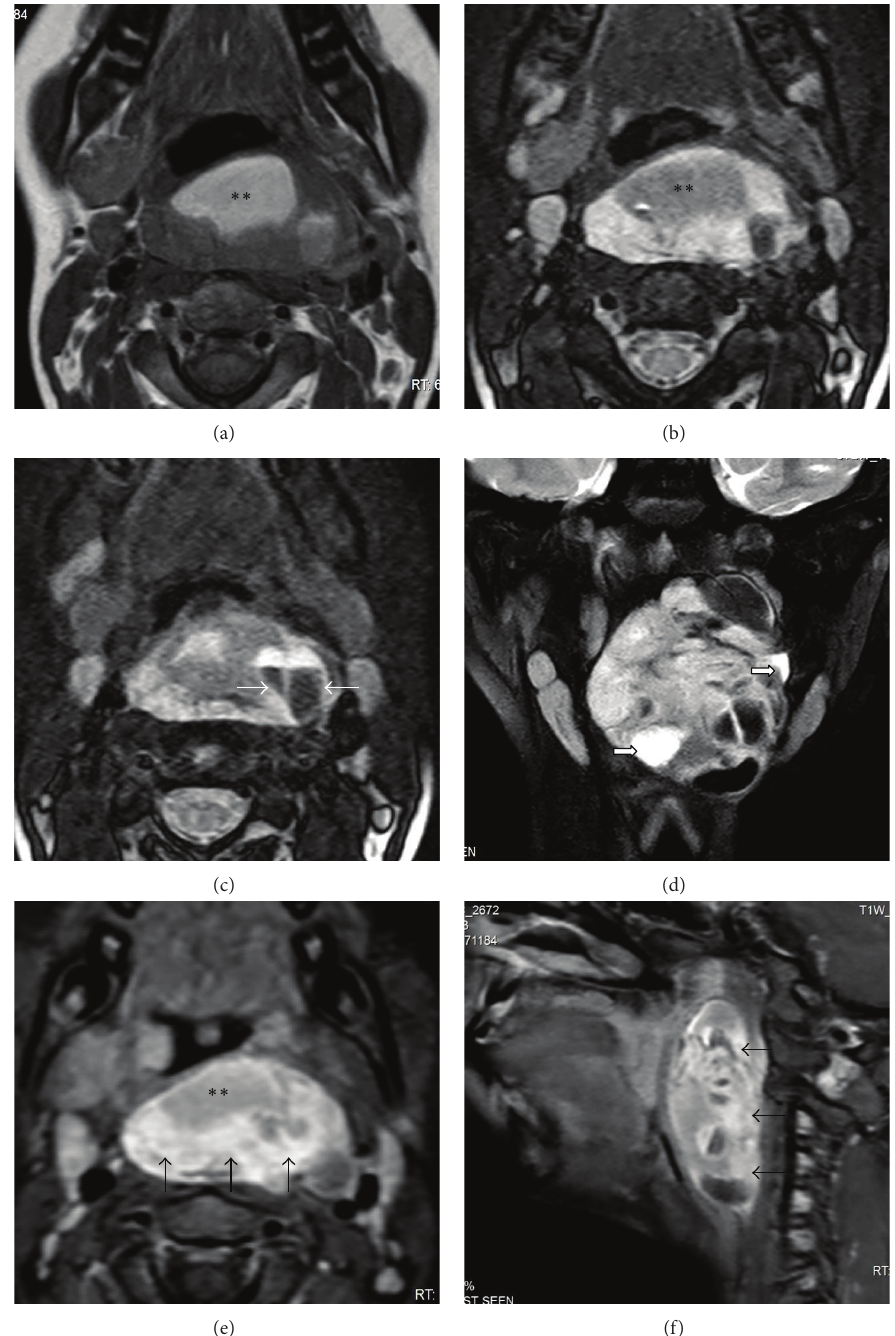
Figure 1: T1W axial (a), STIR axial ((b), (c)), and coronal (d) images showing a large complex signal retropharyngeal mass with a large lipomatous component (asterisk) and multiple fluid-fluid levels (white arrows) and scattered cystic components (block arrows). Postcontrast fat saturated axial (e) and sagittal (f) images reveal dense heterogeneous enhancement within the soft tissue component of the mass (black